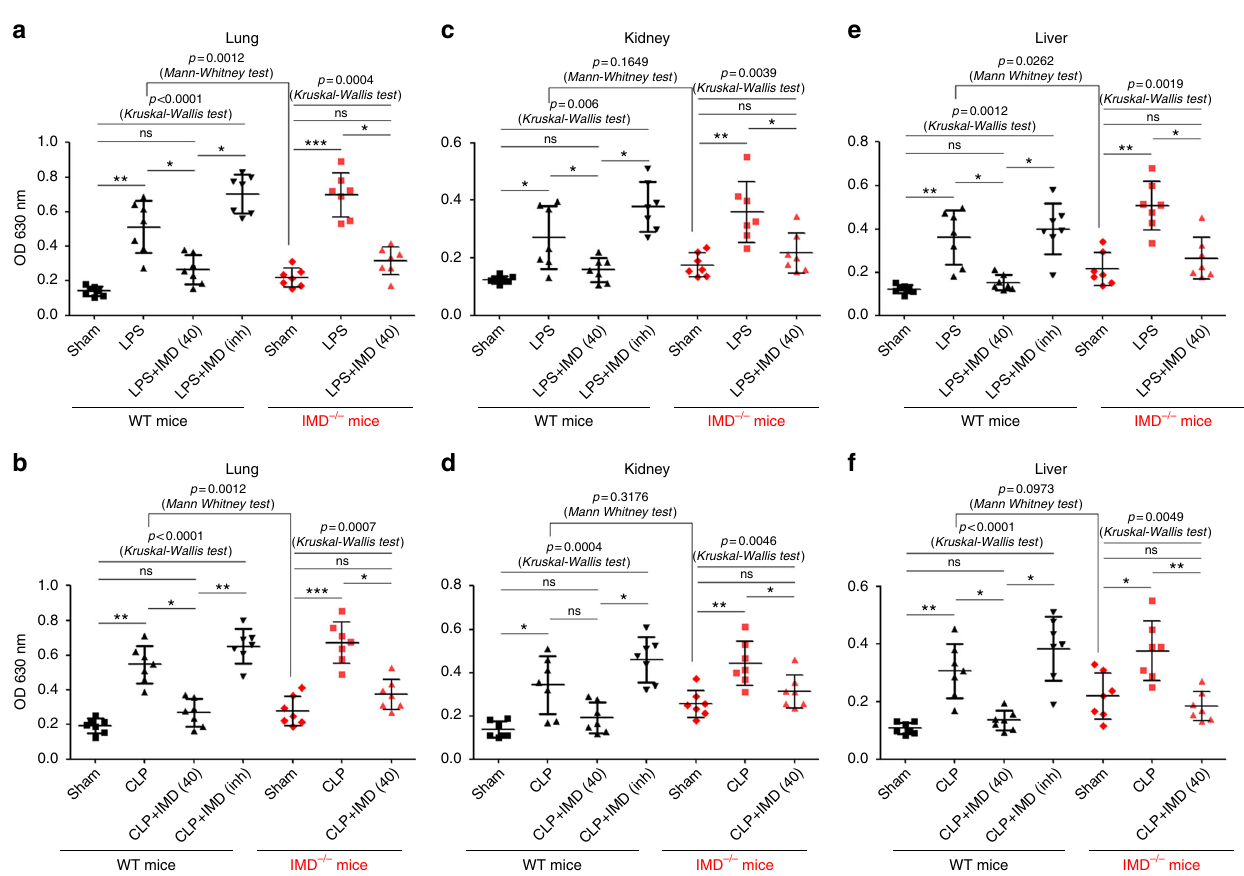
Fig. 3 IMD alleviated the vessel leakage in lung, kidney, and liver. C57/BL6 female (8 – 10 weeks, 20 – 25 g, housed in SPF conditions, n = 7) WT or IMD − / − mice were injected IMD 40 (0.5 mg/kg) or IMD inh (1 mg/kg) subcutaneously 1 h before LPS administration (24 mg/kg) or CLP surgery. The EB leakage of lung, kidney, and liver from LPS-treated mice ( a – c ) or CLP-treated mice ( d – f ) was determined by optical density (OD 630 nm). Data was presented as scatter plots with mean ± SD ( n = 7 per group). Signi fi cance was assessed by Kruskal – Wallis test followed by non-parametric Dunn ’ s post-hoc analysis. The control mice (WT or IMD − / − ) was compared by Mann – Whitney test